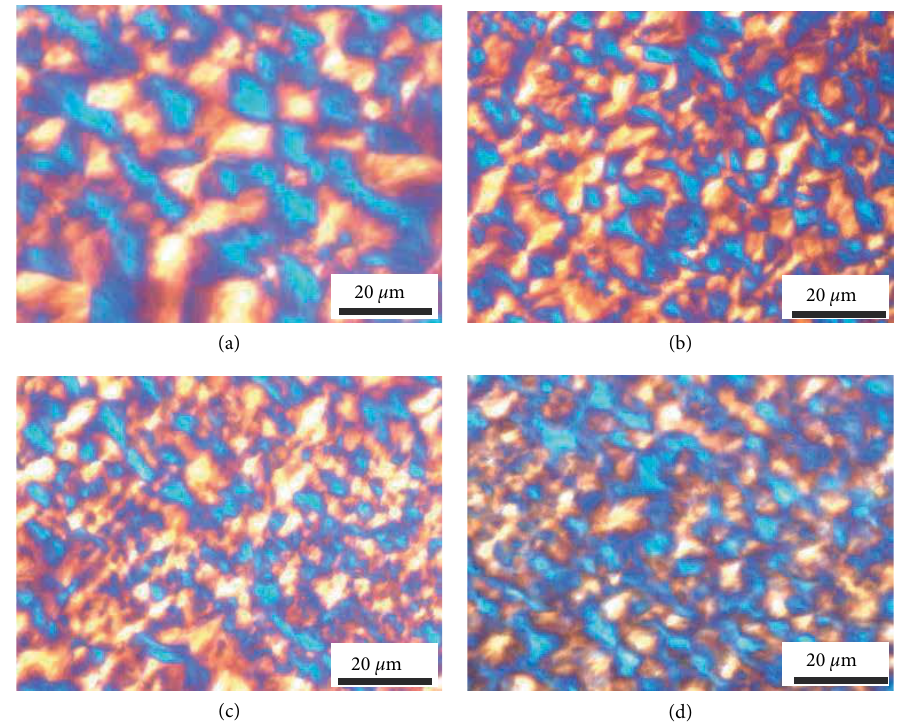
Figure 4: POM of (a) PLLA, (b) PLLA/0.25CNTs, (c) PLLA/0.5CNTs and (d) PLLA/1.0CNTs scaffolds.